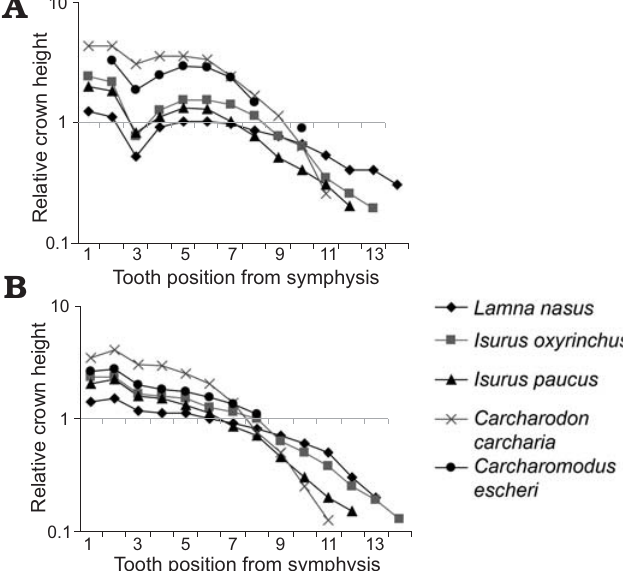
Fig. 13. Relative crown heights of the reconstructed dentition of Carcharomodus escheri (Agassiz, 1843) in comparison to living lamnids. Upper ( A ) and lower ( B ) jaw. Scaled